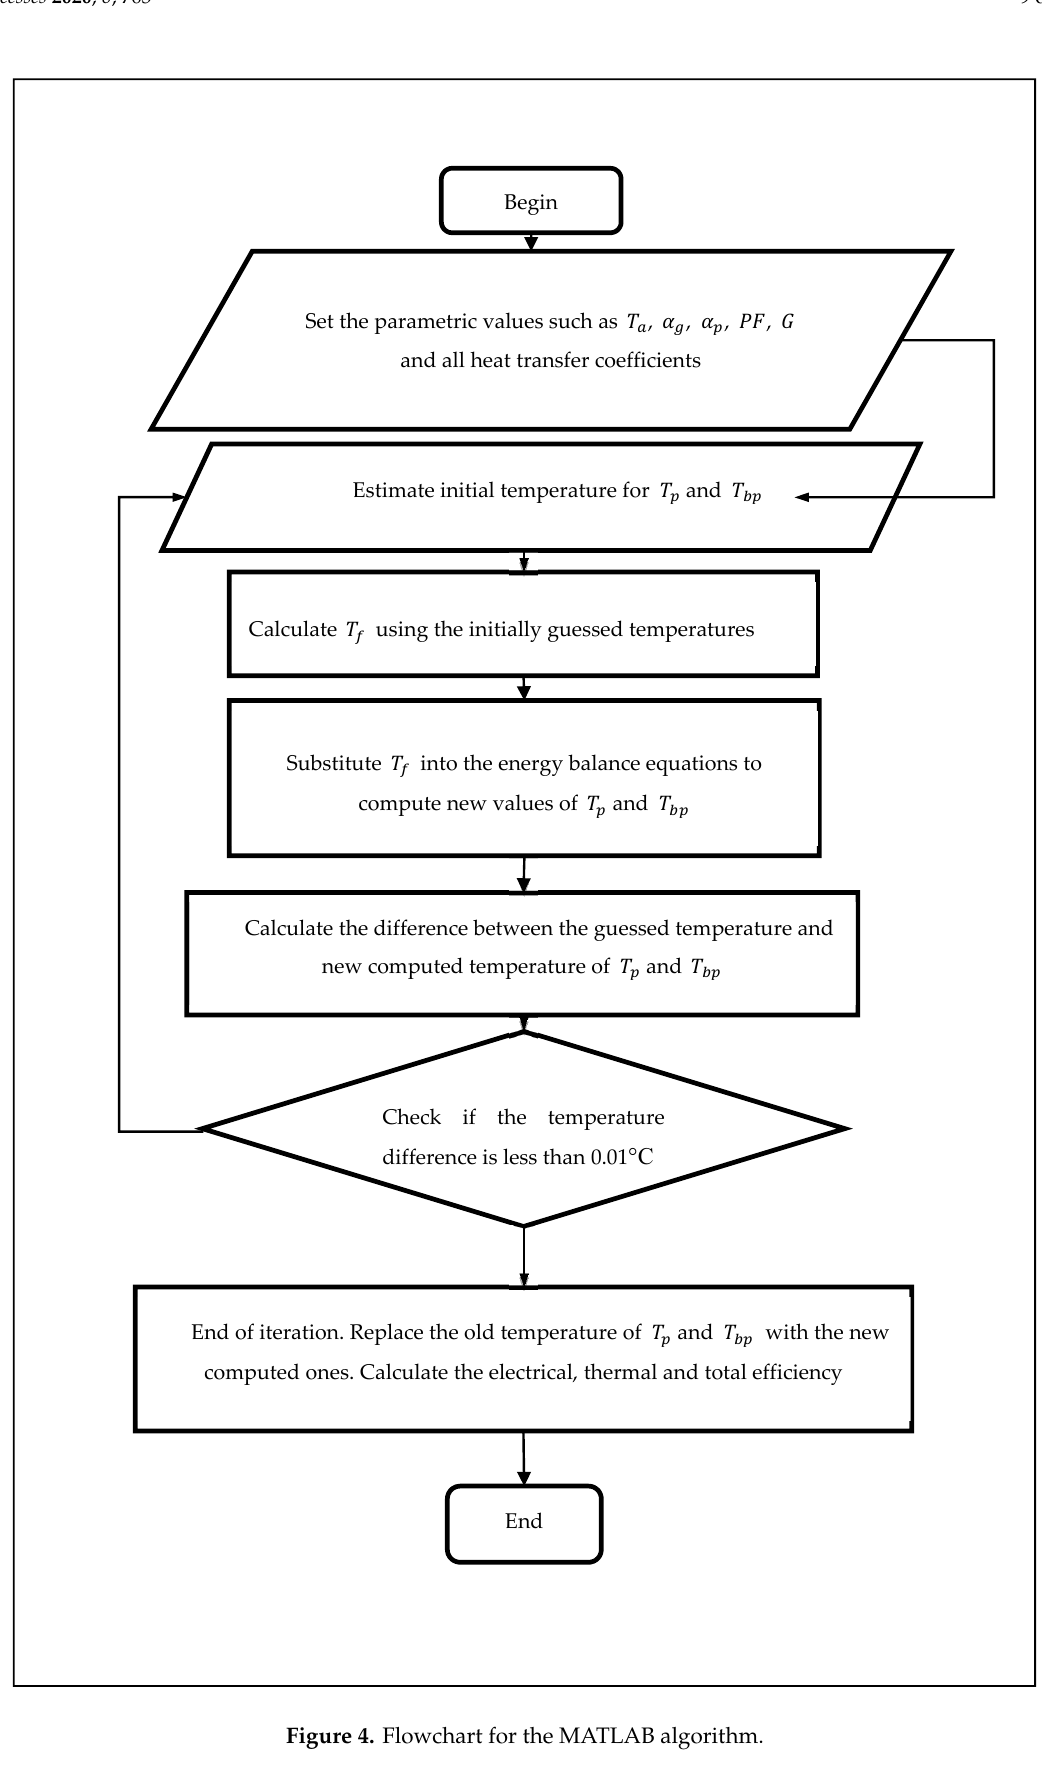
Figure 4. Flowchart for the MATLAB algorithm.